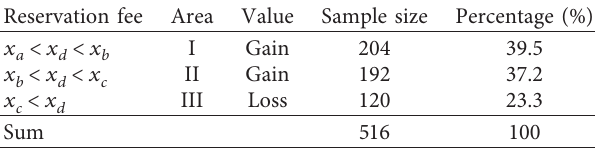
Table 2: Travelers’ choice distribution of reservation fees.